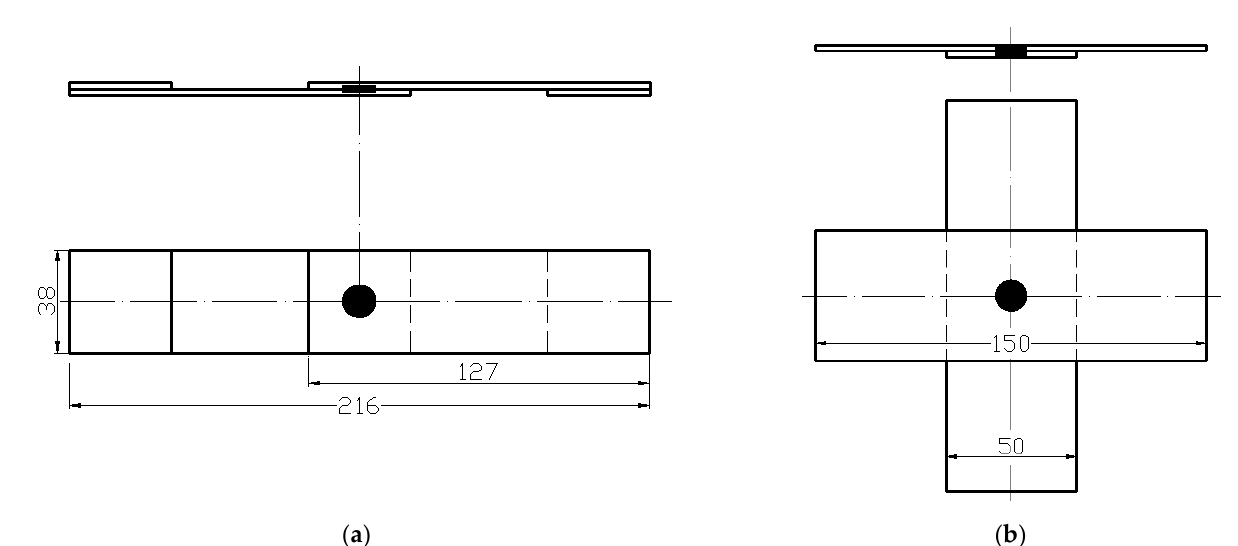
Figure 1. Schematics of resistance welded ( a ) tension-shear, and ( b ) cross-tension specimens (dimensions in mm).